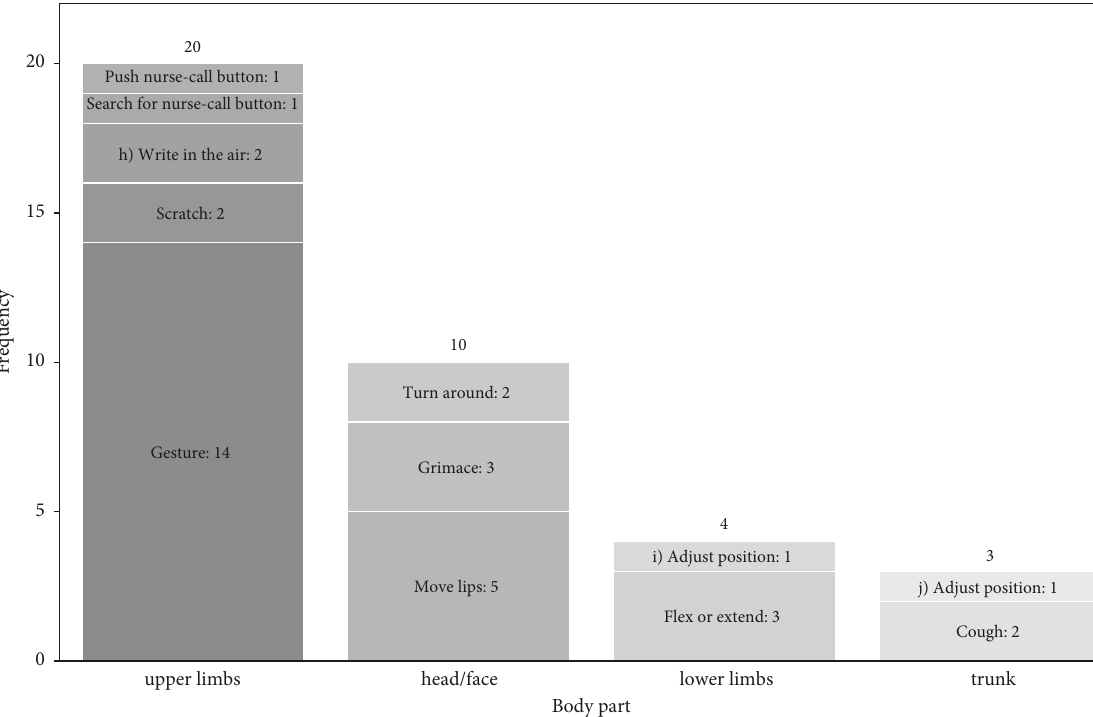
Figure 6: The types of actions patients take to make nurses aware of communication intent ( n � 37). (h) Write in the air with a finger. (i) Adjust the position by abduction, adduction, lateral rotation, or medial rotation of lower limbs. (j) Adjust the position by lifting back or